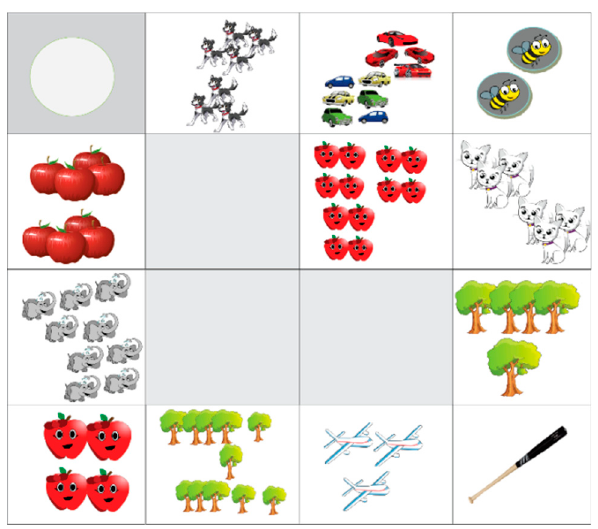
Figure 2. Mat to learn to count directed toward children at preschool level.